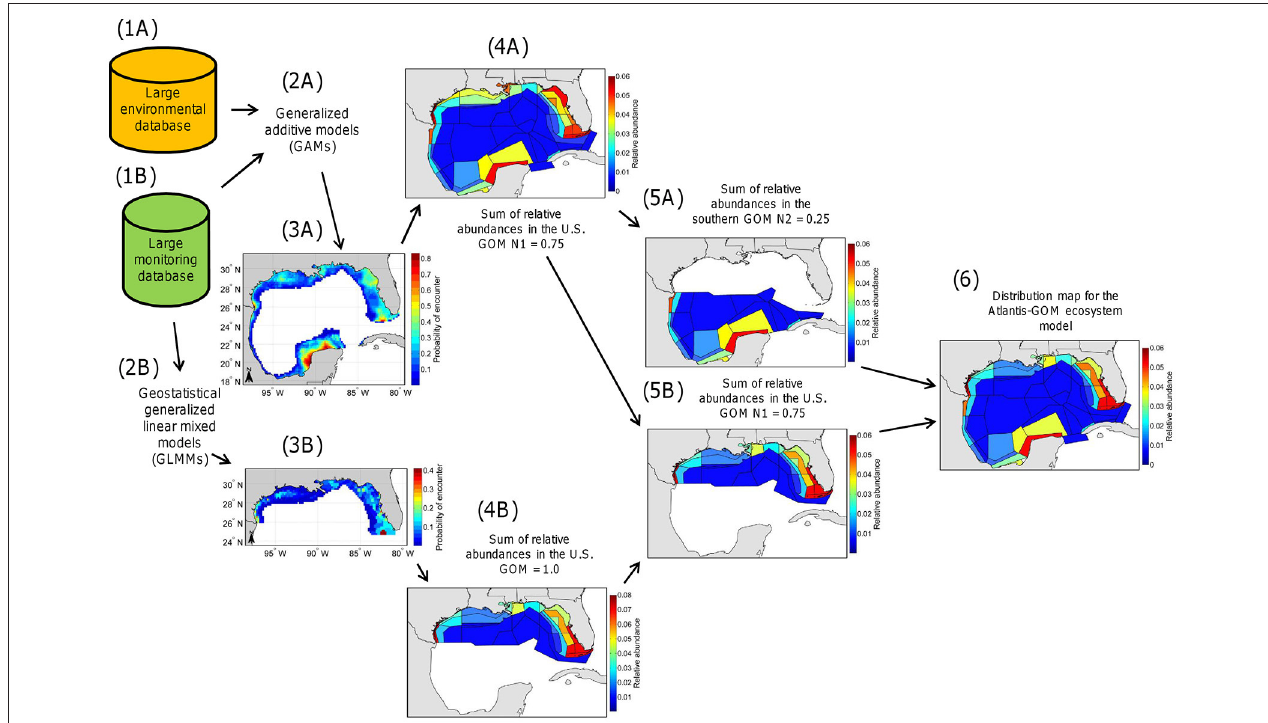
FIGURE 2 | Schematic overview of the methodology developed and employed in the present study. (Step 1A) Construction of a large environmental database for the Gulf of Mexico (GOM) Large Marine Ecosystem (LME). (Step 1B) Construction of a large monitoring database for the northern (U.S.) GOM. (Step 2A) Fitting of binomial generalized additive models (GAMs) to the large environmental and monitoring databases and validation of the GAMs. (Step 2B) Fitting of geostatistical binomial generalized linear mixed models (GLMMs) to the large monitoring database and validation of the geostatistical GLMMs. (Step 3A) Production of long-term probability of encounter maps from GAM predictions. (Step 3B) Production of long-term probability of encounter maps from geostatistical GLMM predictions. (Step 4A) Production of maps of relative abundance for the GOM LME from the maps produced in Step 3A (such that the sum of relative abundances for each map is equal to 1.0). In this example, the sum of relative abundances in the U.S. GOM is equal to N1 = 0.75 and the sum of relative abundances in the southern GOM is equal to N2 = 0.25. (Step 4B) Production of maps of relative abundance for the U.S. GOM from the maps produced in Step 3B (such that the sum of relative abundances for each map is equal to 1.0). (Step 5A) Production of maps of relative abundance for the southern GOM from the maps produced in Step 4A (such that, in this example, the sum of relative abundances for the map for the southern GOM is equal to N2 = 0.25). (Step 5B) Production of maps of relative abundance for the U.S. GOM from the maps produced in Step 4B , rescaled to account for relative abundance in the U.S. GOM relative to the southern GOM according to the map produced in Step 4A (such that, in this example, the sum of relative abundances for the map for the U.S. GOM is equal to N1 = 0.75). (Step 6) Combination of the maps of relative abundance for the southern and U.S. GOM to generate distribution maps usable in the Atlantis-GOM ecosystem model (such that the sum of relative abundances for each distribution map for Atlantis-GOM is equal to